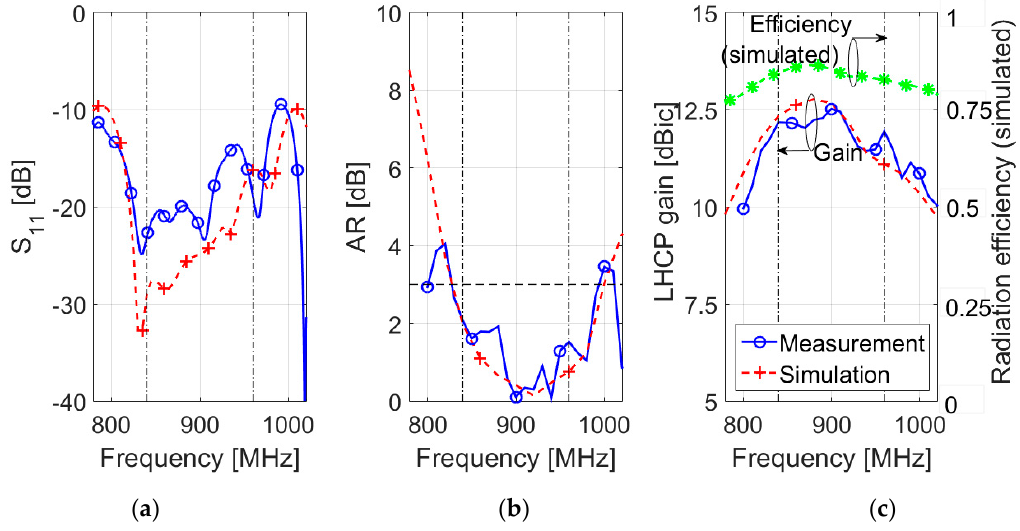
Figure 8. Comparison of simulation and measurement results: ( a ) S 11 , ( b ) AR, and ( c ) broadside LHCP gain and simulated radiation efficiency (AR and gain measurement results available from 800 MHz).